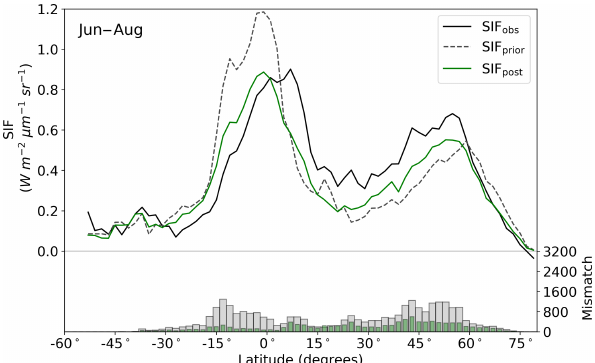
Figure 5. Latitudinal averaged SIF and mismatch with observa- tions. OCO-2 observations (black line), SIF prior (gray dashed line, gray bars) and SIF post (green line, green bars) for northern sum- mer (June–August). Data are only shown for spatiotemporal points where OCO-2 observations are